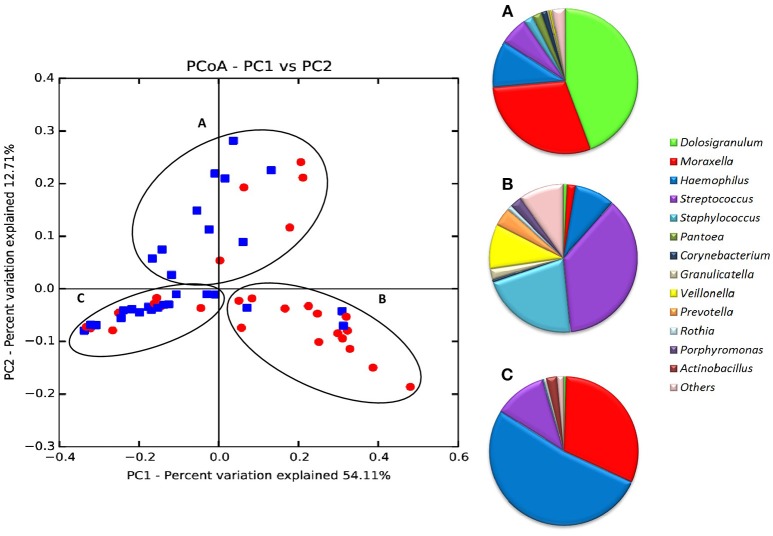
Principal Coordinates Analysis (PCoA) of all 56 nasopharyngeal samples according to bacterial composition. Data include IPD patients (red-dots) and healthy controls (blue dots). PCoAs were performed with weighted UniFrac analysis with clustering at the species taxonomic level (97% sequence identity) with 1,000 reads per sample. The taxonomic composition (proportion of bacterial genera) of the 3 microbiota types (“nasopharyngeal-types”) is shown to the right. Data in (A–C) were obtained from 1,000 randomly selected sequences per sample.